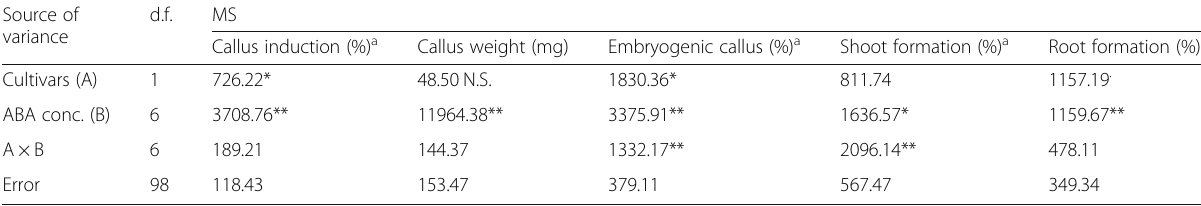
Table 1 Analysis of variance of the effects for callus induction (%), callus weight (mg), embryogenic callus (%), shoot formation (%), root formation (%), and their interactions Source of variance